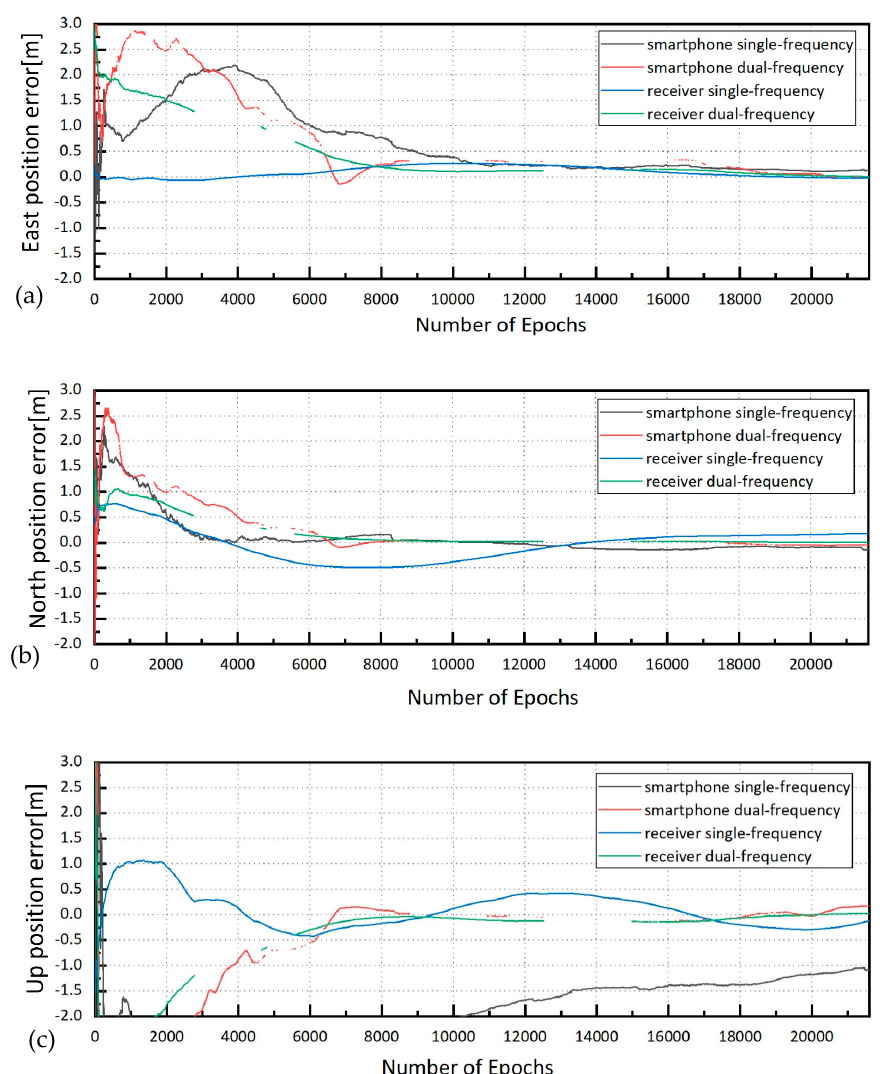
Figure 5. Position errors of smartphone and receiver (( a ): east position errors; ( b ): north position errors; ( c ): up position errors).